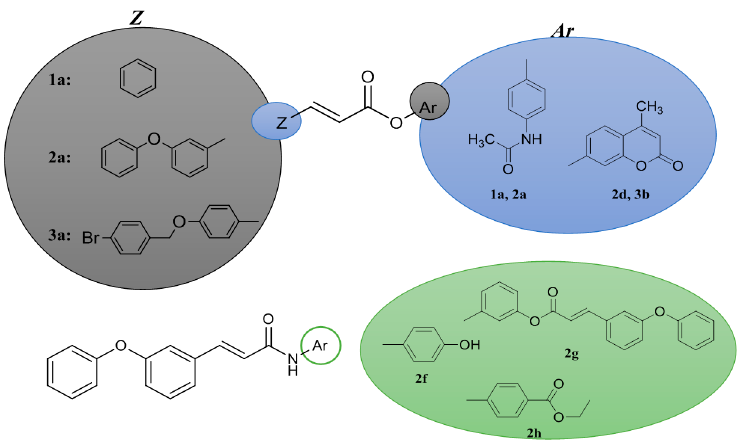
Figure 1. Cinnamic acid-based hybrids.